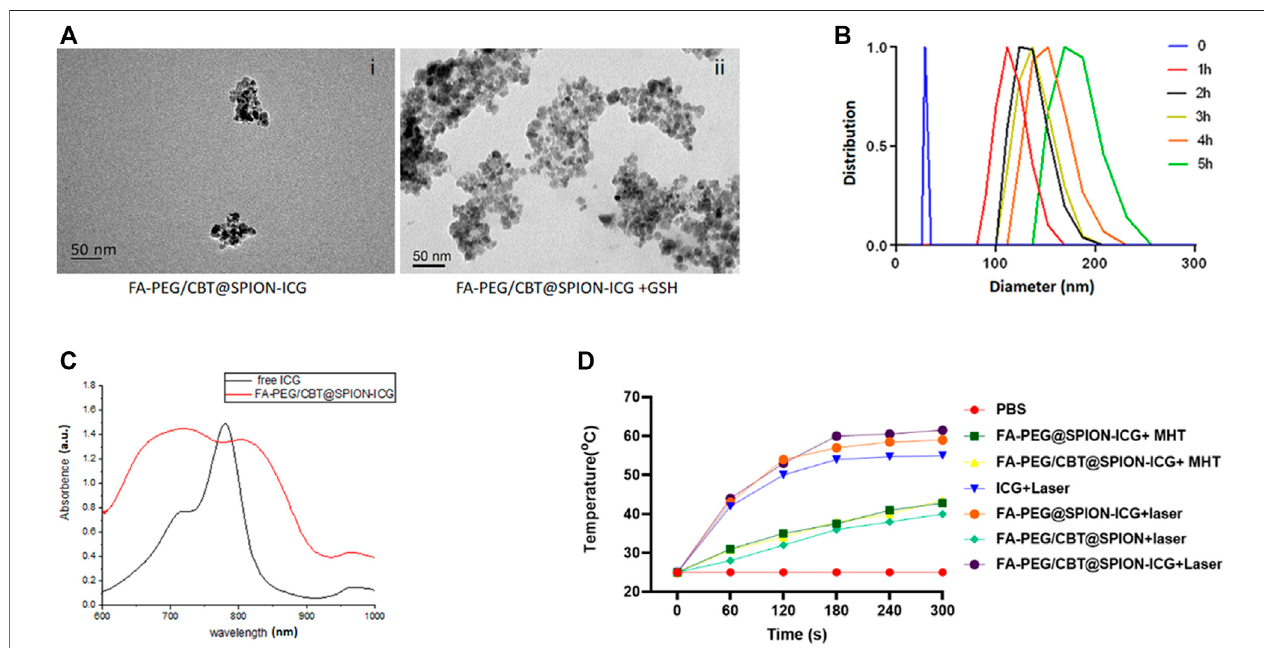
FIGURE2| CharacterizationofFA-PEG@SPION-ICG.TEMimagesofFA-PEG/CBT@SPION-ICG(i)andFA-PEG/CBT@SPION-ICGafterbeingtreatedbyGSH(ii). DLSdiagramofFA-PEG/CBT@SPION-ICGafterbeingtreatedbyGSH (B) .UVabsorptionspectrumoffreeICGandFA-PEG/CBT@SPION-ICG (C) . Invitro temperature pro fi le (D)